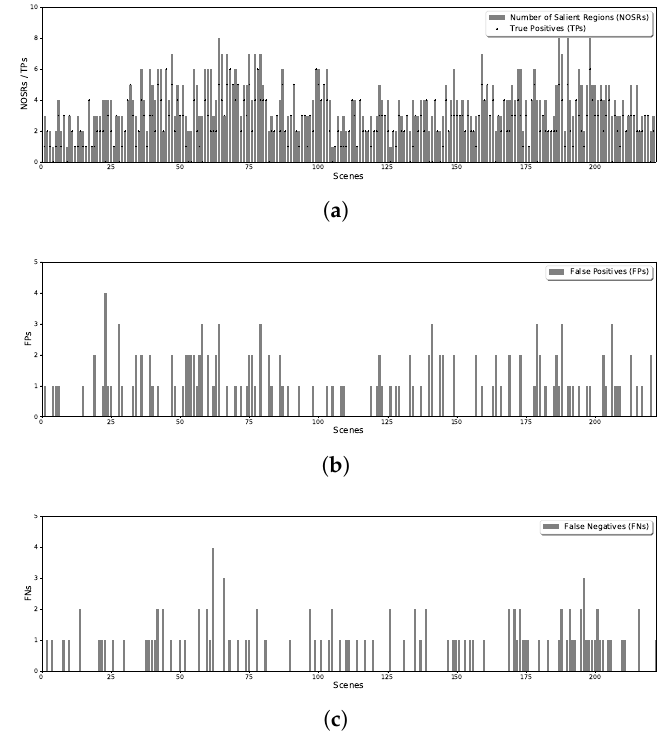
Figure 8. Statistical Results of V-shape Formation Case. ( a ) True Positives of Each Scene; ( b ) False Positives of Each Scene; ( c ) False Negatives of Each